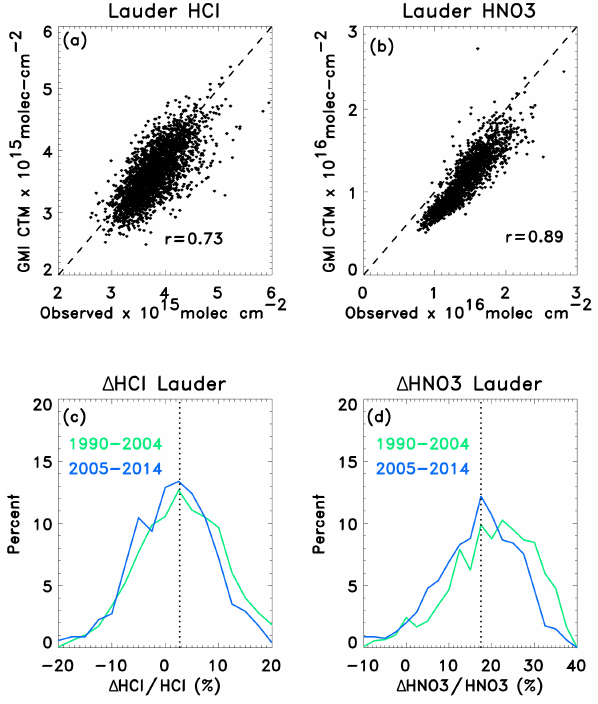
Figure 11. The GMI CTM and observed columns at Lauder sta- tion in 1990–2014 for (a) HCl and (b) HNO 3 . Histogram of the percentage difference between simulated and observed columns in 1990–2004 (blue) and 2005–2014 (green) for (c) HCl and (d) HNO 3 .